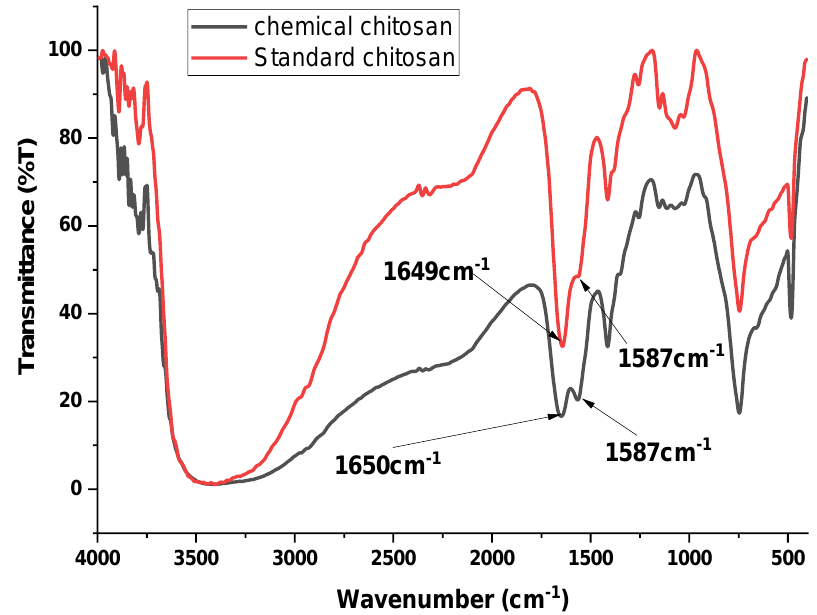
Figure 2. FTIR spectra of chemically extracted chitosan from BSF pupal exuviae, compared to the standard shrimp chitosan (Sigma-Aldrich, St. Louis, MI, USA).